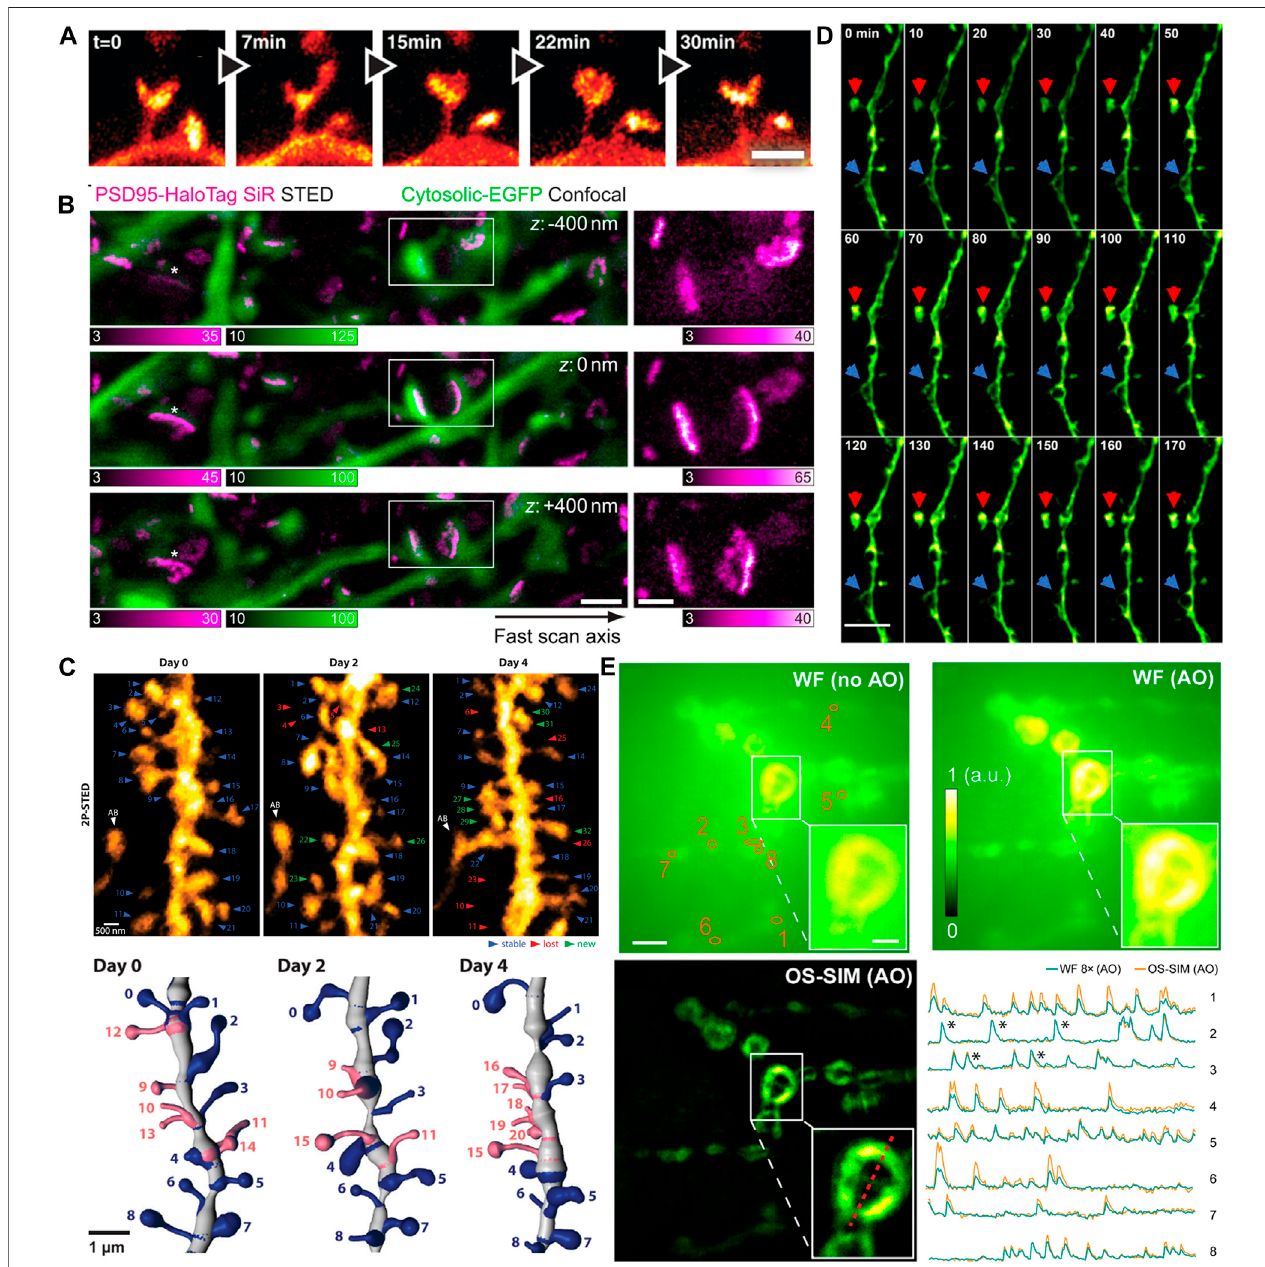
FIGURE 8 | Examples of in vivo super-resolution images in the fi eld of neurosciences. (A) Dynamics of spines in the molecular layer of the somatosensory cortex with STED microscopy (Berning et al., 2012). Scale bar, 1 μ m. Reprinted from Berning et al. (2012) with permission from American Association for the Advancement of Science. (B) The 3D images of PSD95 scaffold morphologies in living mouse. Scale bars, 1 μ m in original images, 500 nm in magni fi ed views (Masch et al., 2018). Reprinted from Masch et al. (2018) with permission from National Academy of Sciences of the United States of America. (C) 2P-STED images of the dendrite over 4 days(Pfeifferetal.,2018).ReprintedfromPfeifferetal.(2018)withpermissionfromeLifeSciences. (D) Time-lapse invivo SIMimagesshowingstructuraldynamicsofa dendrite in the brain of a Thy1-GFP line M mouse after KCl injection. Arrows point to highly dynamic structures (Turcotte et al., 2019). Scale bar: 4 µm. Reprinted from Turcotte et al. (2019) with permission from National Academy of Sciences of the United States of America. (E) In vivo functional imaging of quantal releases of a Drosophila larva neuromuscular junction with AO OS-SIM (Li et al., 2020). Calcium transients from eight orange regions in wild fi eld view. Scale bars indicated 5 µm in original images and 2 µm in the insets. Reprinted from Li et al. (2020) with permission from American Association for the Advancement of Science.